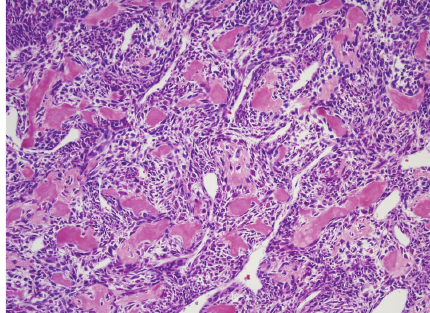
Figure 12: Histologic examination of area shown in Figure 11 showed atypical, hyperchromatic spindle cells and osteoid forma- tion, consistent with osteosarcoma (hematoxylin and eosin stain,